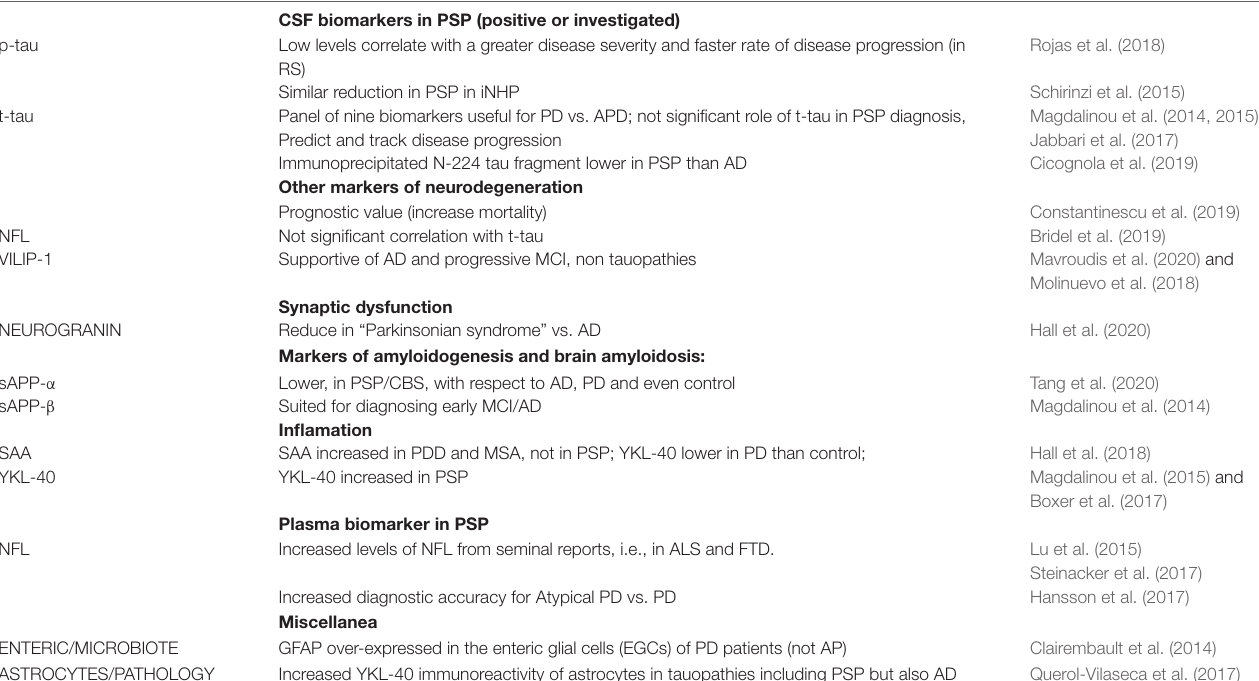
TABLE 1 | Main available biomarkers for